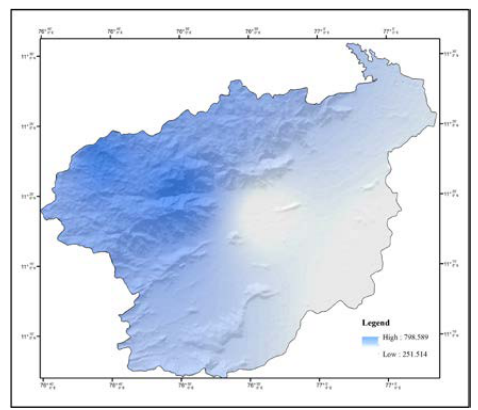
Figure 4. Rainfall Erosivity (R)